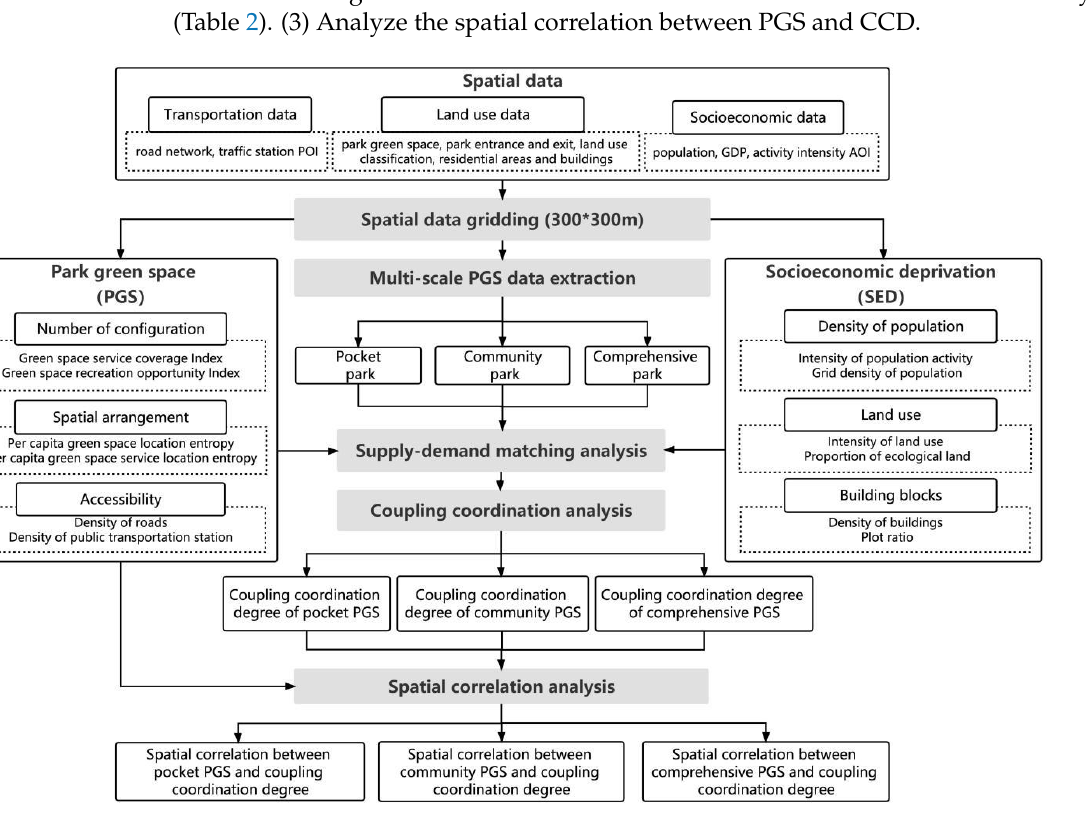
Figure 1. Study framework. Table 1. Basic information on 3-scale